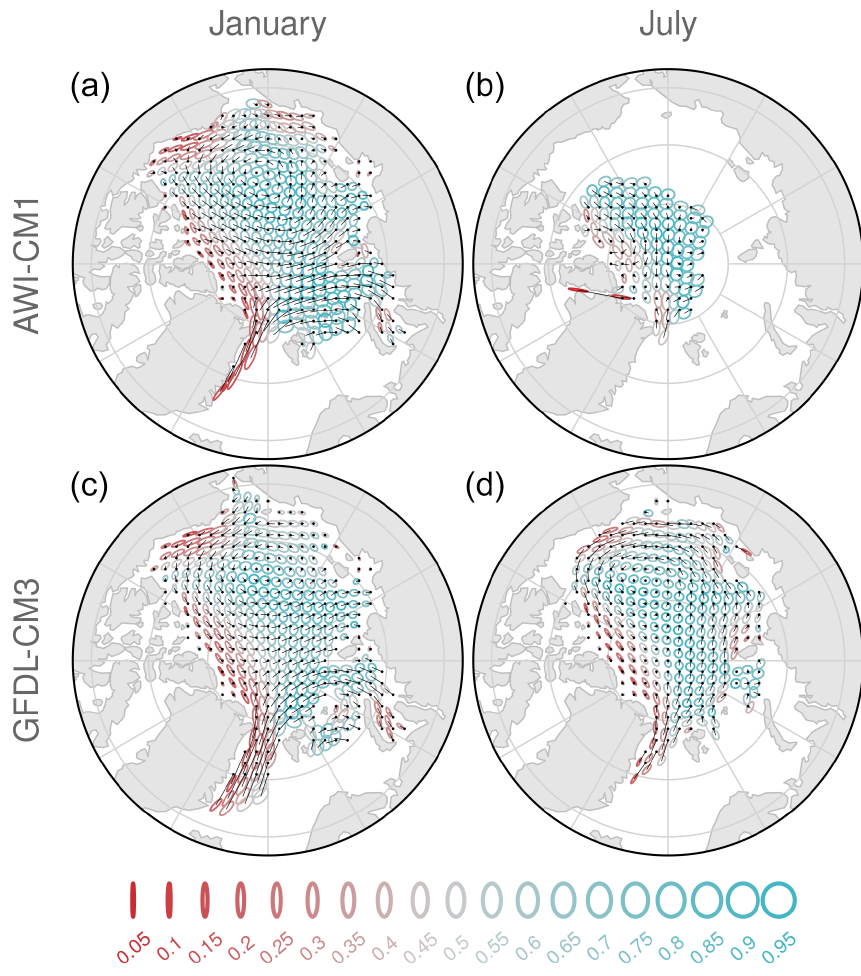
Figure 4. Variance ellipses (here scaled for showing the 20% confidence level, scale chosen for best visibility) for the target position at t = 45d lead time, generated from trajectories from all available control run years; we only show those initial positions for which the targets of at least 180 single years remained in the ice cover for up to t = 45d. Each row shows ellipses for initializations in January (a, c) and July (b, d) . The coloring denotes the axis ratio (anisotropy) of the uncertainty; the black dots show the corresponding initial positions, connected by thin black lines to the ellipse centers, which indicate the average positions after